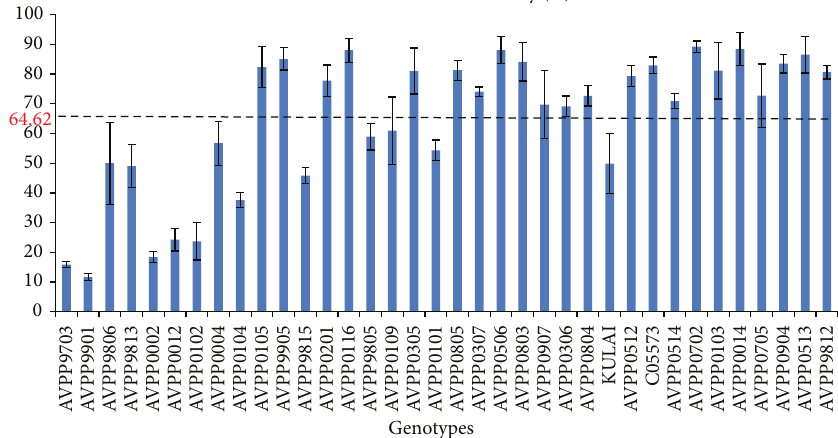
Figure 1: Variation among 36 chili pepper genotypes in cell membrane thermostability.